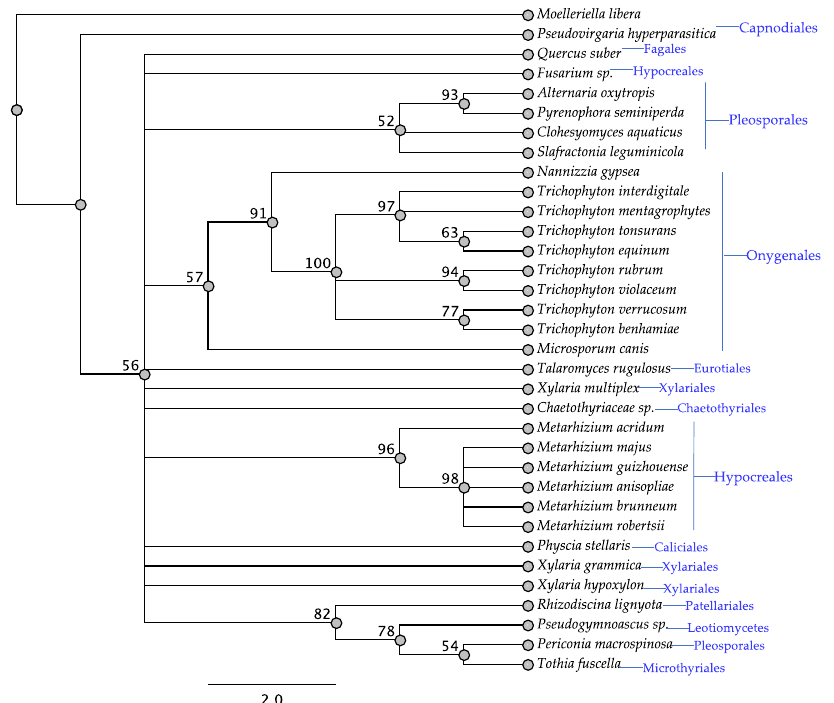
Figure 3. Maximum parsimony protein tree resulting from the analysis of SwnN. Bootstrap confidence values from 1000 bootstrap replicates are presented at each corresponding node. Moelleriella libera (Hypocreales) was used as the outgroup and obtained from NCBI database, GenBank accession: KZZ92942.1. Fungal orders are indicated next to each organism/clade. The swnH1 gene was found in all fungi except for Rosellinia necatrix , Xylaria polymor- pha , and Pseudovirgaria hyperparasitica (Table 1). All taxa that have been reported to contain swainsonine contain swnH1 (Table 1). The SwnH1 tree showed a similar pattern to the SwnK tree where similar members of the Hypocreales, Onygenales, and Xylariales, and some Pleosporales grouped together (Figure 4).